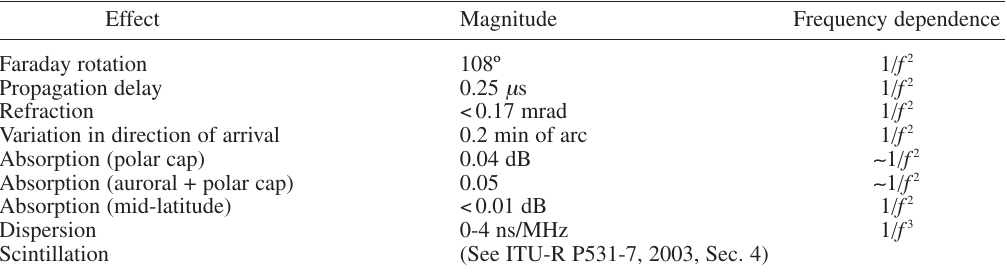
Table 1.II. Estimated maximum ionospheric effects at 1 GHz for elevation angles of about 30º one-way tra- versal (ITU-R P531-7,